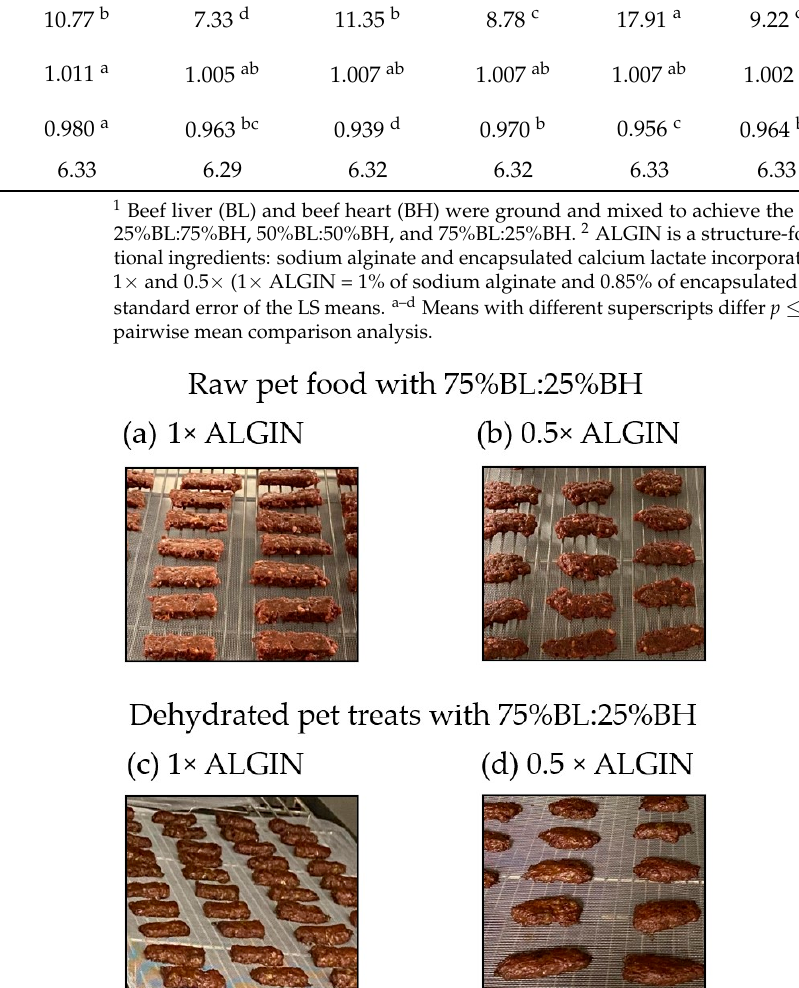
Figure 1. Raw pet food ( a , b ) and dehydrated pet treats ( c , d ) containing 75% beef liver (BL) and 25% beef heart (BH) and either 1× (1% sodium alginate + 0.85% encapsulated calcium lactate) or 0.5× (0.5% sodium alginate + 0.425% encapsulated calcium lactate) ALGIN exhibit visible differences in three-dimensional structure.